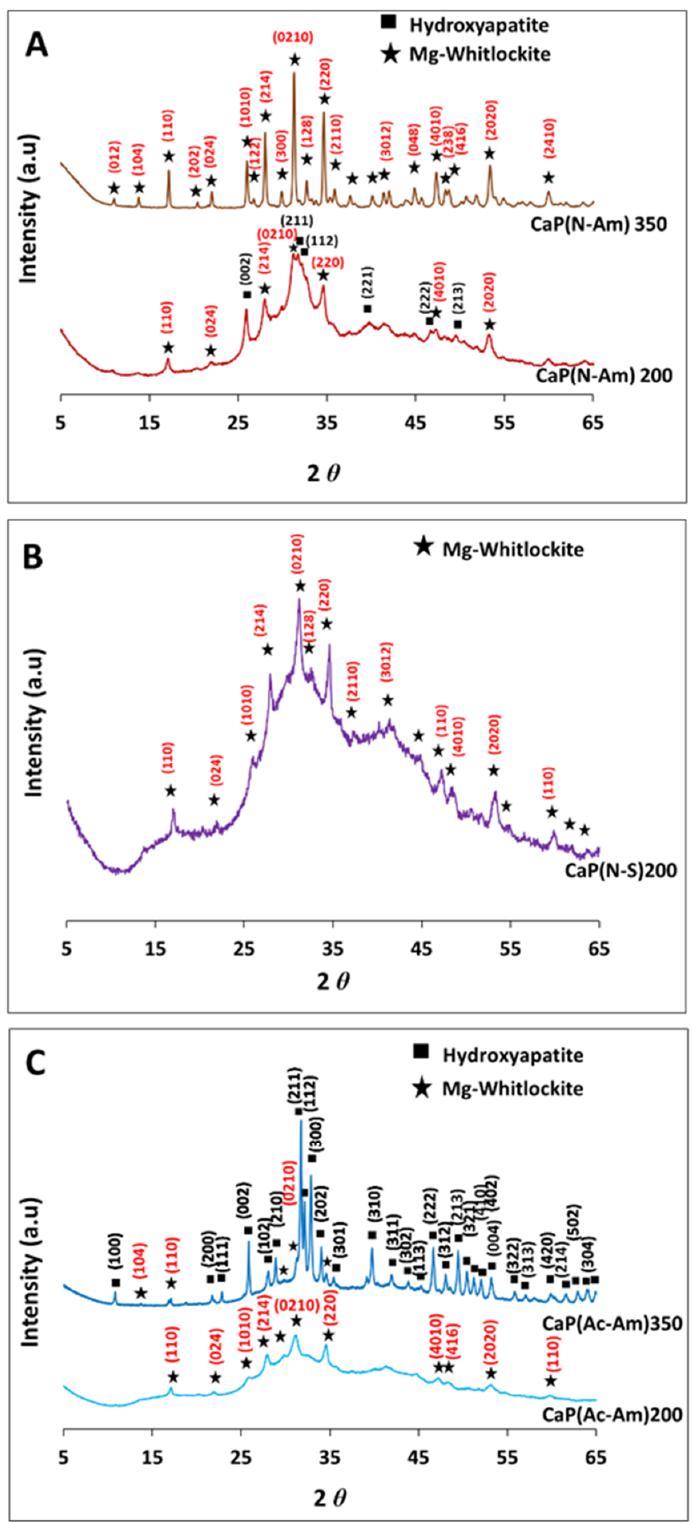
Figure 1. The XRD spectra of samples synthesised at 200 °C and 350 °C via a hydrothermal synthesis process at constant pH 11 of calcium nitrate tetrahydrate solution and pH 6 of struvite solution adjusted using ( A , C ) NH 4 OH (Am) and ( B ) NaOH (S), individually where struvite was dissolved in ( A , B ): HNO 3 (N) and ( C ) CH 3 COOH (Ac). Calcium nitrate tetrahydrate was dissolved in DI water